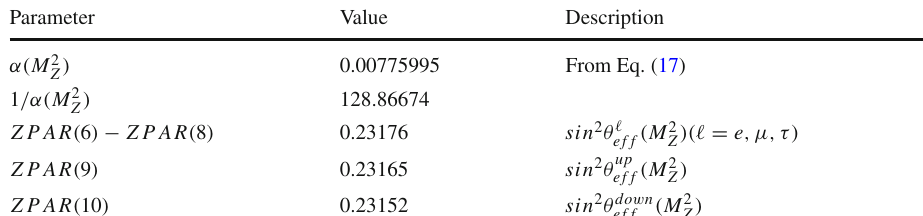
Table 8 The effective weak mixing angles sin 2 θ f different mass windows with/without box